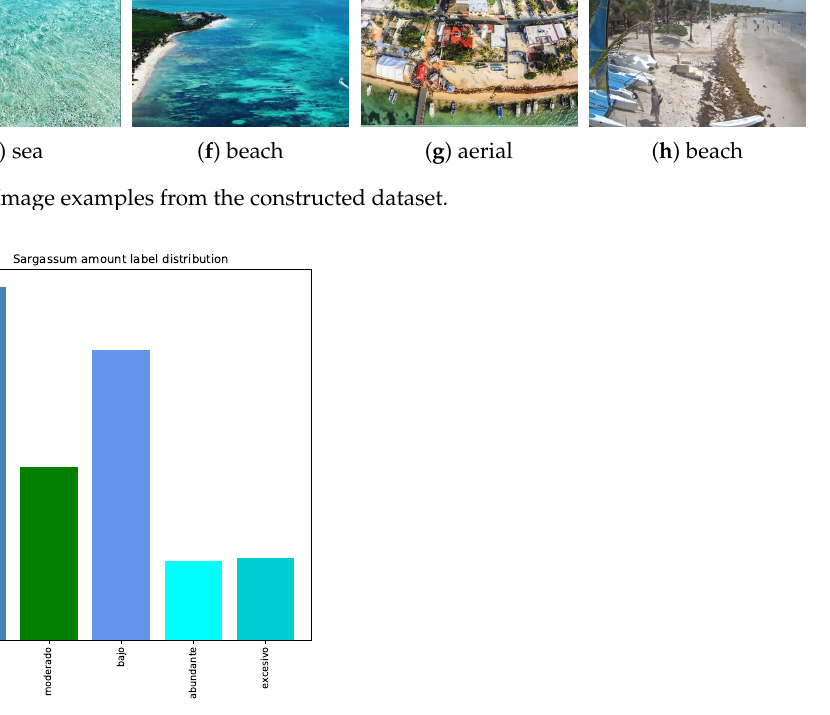
Figure 2. Distribution of labels for characterizing the amount of Sargassum in images. The labels were defined using Spanish words. They are nada (nothing), bajo (low), moderado (mild), abundante (plenty), and excesivo